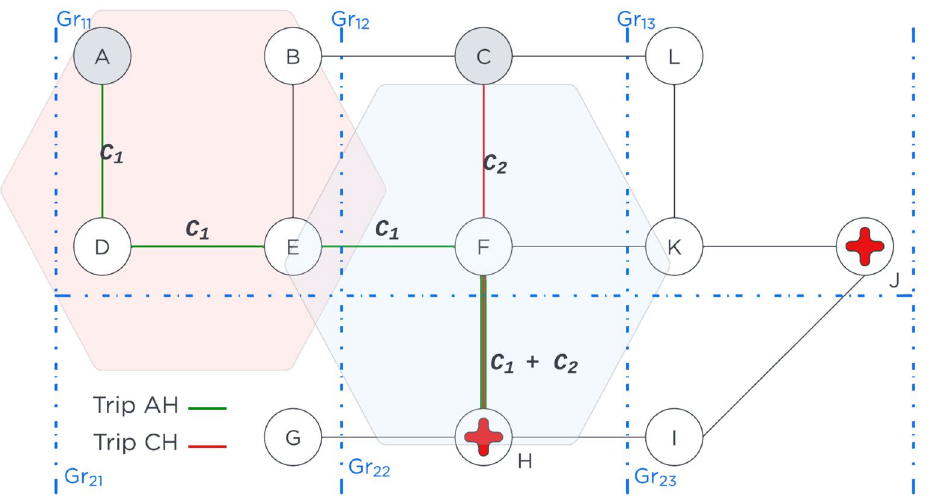
Figure 2. Simplified hypothetical city example for methodology illustration